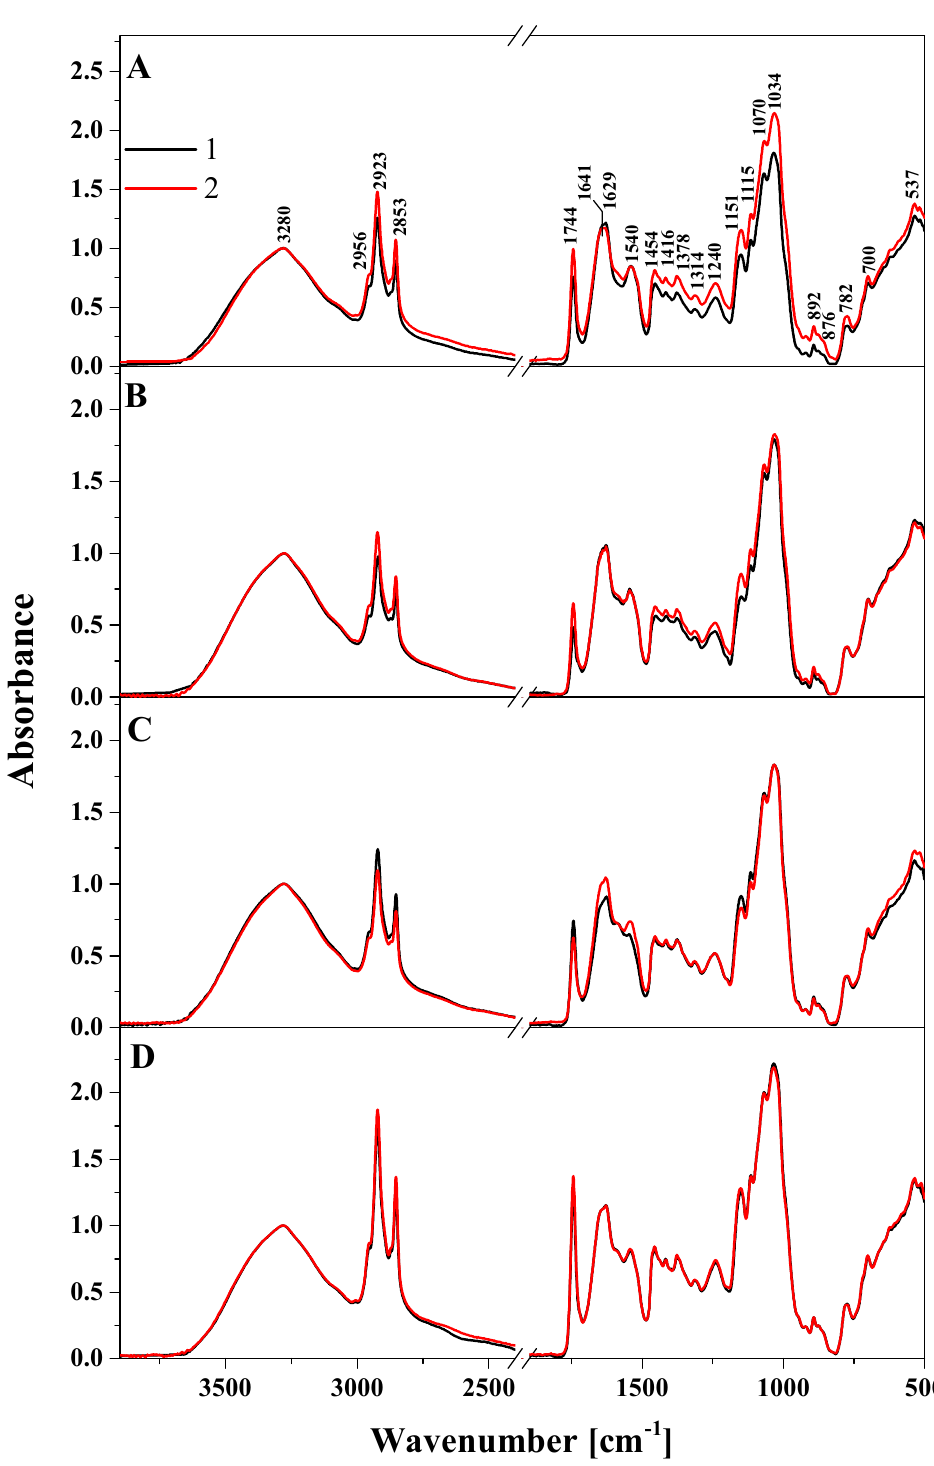
Figure 5. Panel ( A )—28.09 (‘’0” day of storage), panel ( B )—5.10 (“7” day of storage), panel ( C )—12.10 (“14” day of storage), and panel ( D )—19.10 (“21” day of storage). Black line—plain, natural probiotic yoghurt; red line—probiotic yoghurt with sea buckthorn mousse. Table 5. The location of the maxima of the Fourier Transform Infrared (FTIR ) absorption bands, with assignment of particular vibrations to the respective samples, registered within the spectral range of 700–3700 cm − 1 [45,47–59].